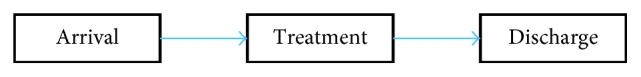
High-level process flowchart.